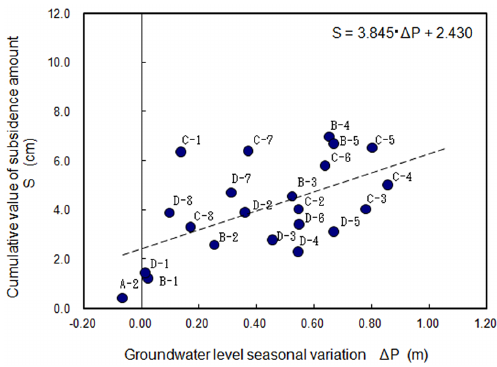
Figure 10. Cumulative value of land subsidence and seasonal vari- ation groundwater level.